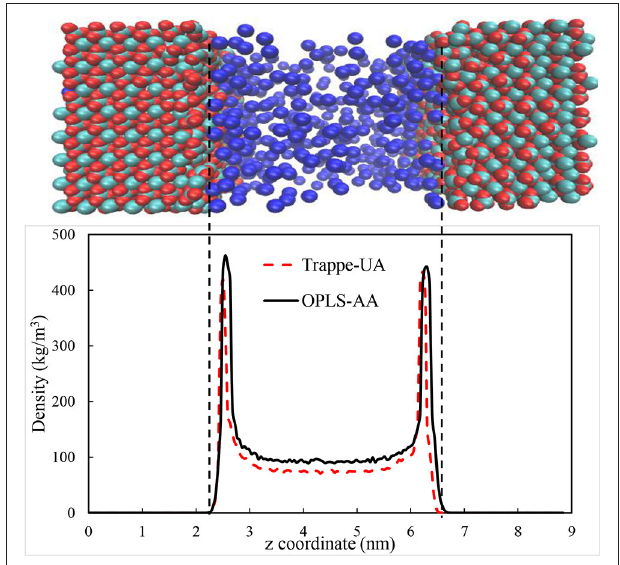
FIGURE 2 | The distribution of methane in 4nm calcite nanopore under 375K and density of 96 Kg/m 3 . The calcium, carbonate and methane species are shown by cyan, red, and blue colors,